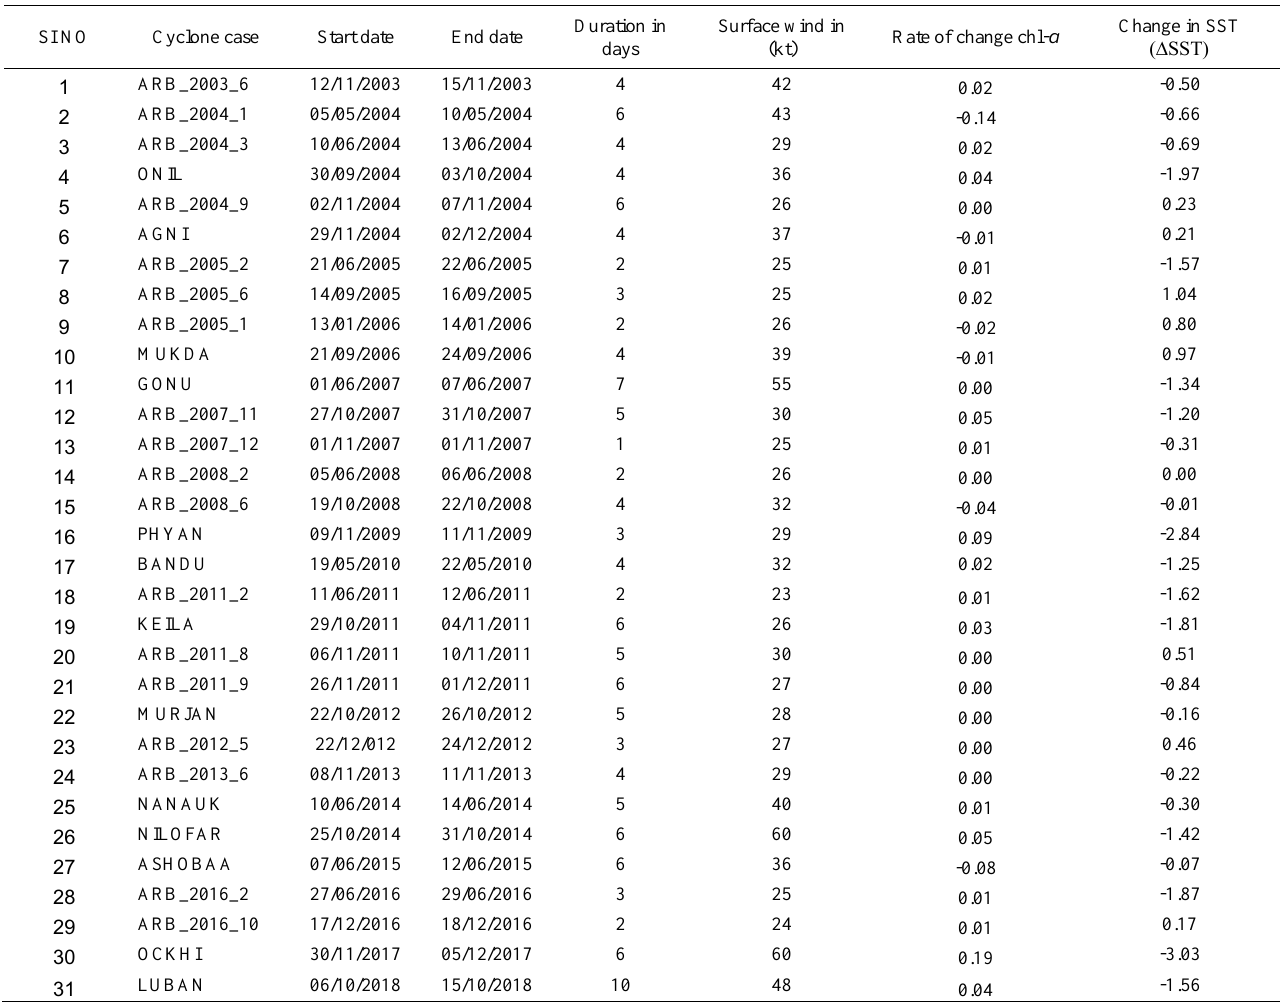
Table 1. Summary of 31 cyclone cases occurred in the Arabian Sea from 2003 to 2018